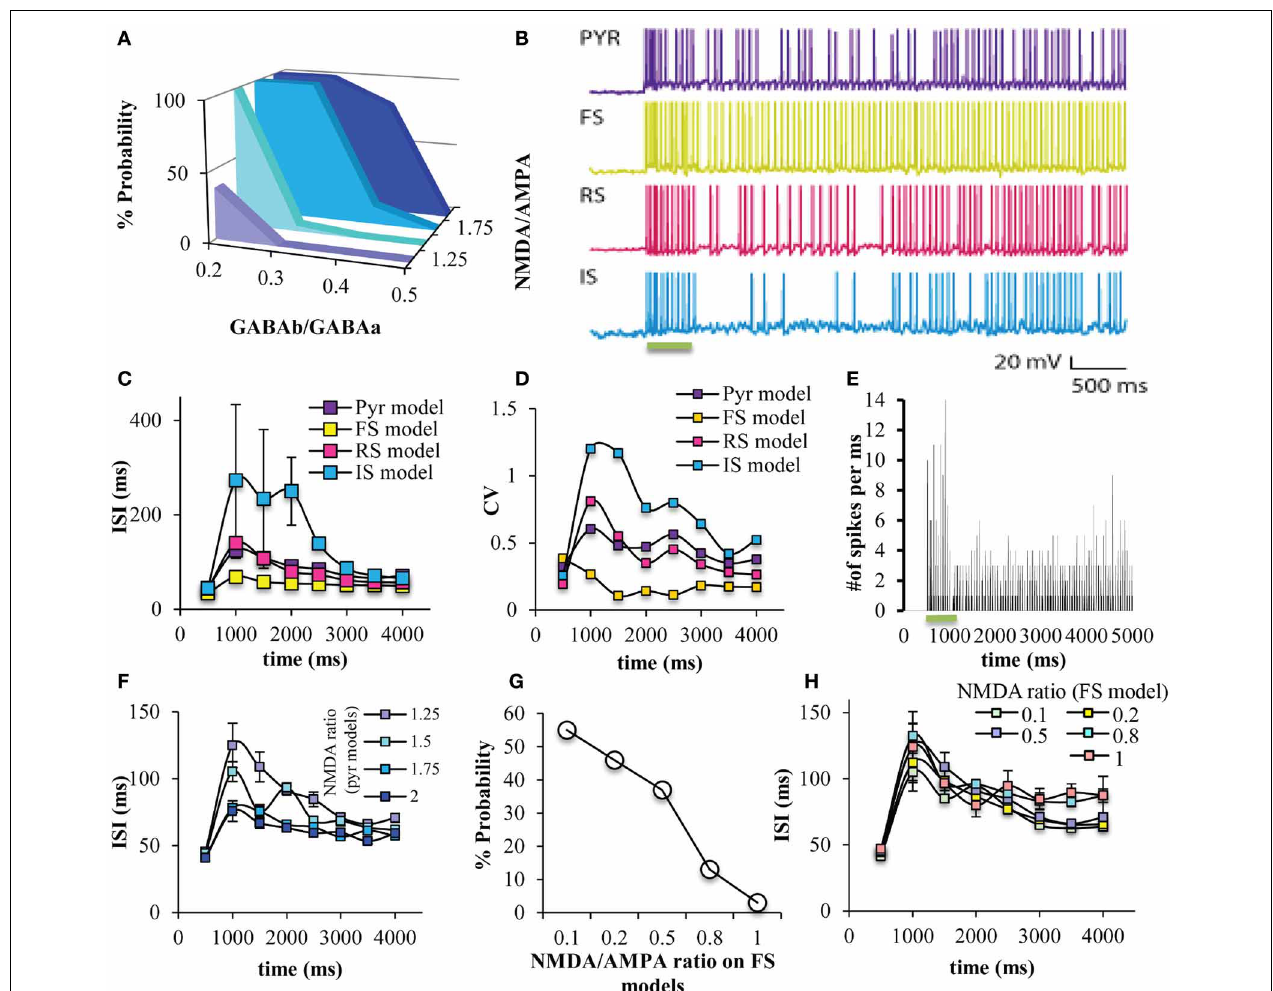
FIGURE 5 | Persistent activity induction in the network. (A) The probability of persistent activity induction (measured out of 100 trials) was dependent on the GABAB-to-GABAA and NMDA-to-AMPA ratio on the pyramidal model neurons, as previously seen (Papoutsi et al., 2013). (B) Representative traces of all neuron models during the stimulus and during persistent activity. (C) Graph showing the ISIs during the stimulus and persistent activity in 500ms bins, for all neuron models. (D) Graph showing the coefficient of variation during the stimulus and persistent activity in 500ms bins, for all neuron models. The ISI is increased during the initial